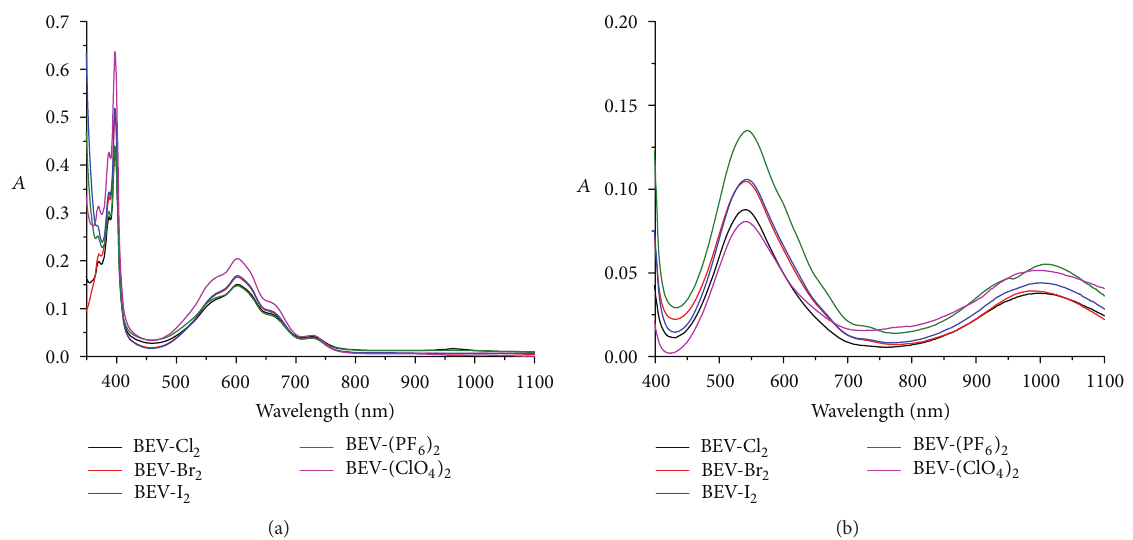
Figure 5: The absorption spectra of BEV-X 2 ( 1 × 10 −5 M) after reduction with Na 2 S 2 O 4 (8–10eq) under Ar atmosphere, (a) without CB [8] , and (b) with the presence of 1 equivalent CB [8]